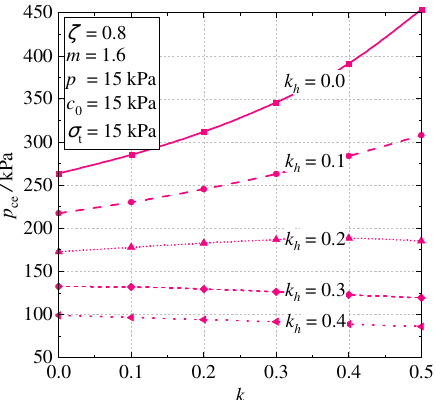
Figure 7. Influence of seismic coefficients on the seismic bearing capacity.